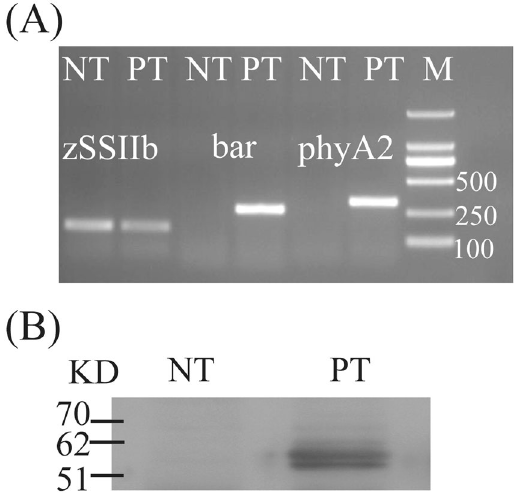
Figure 1. Detection of the exogenous gene expression and target proteins in maize seeds. ( A ) RT-PCR results for the exogenous genes in maize seeds; ( B ) Western blot analysis of target proteins in maize